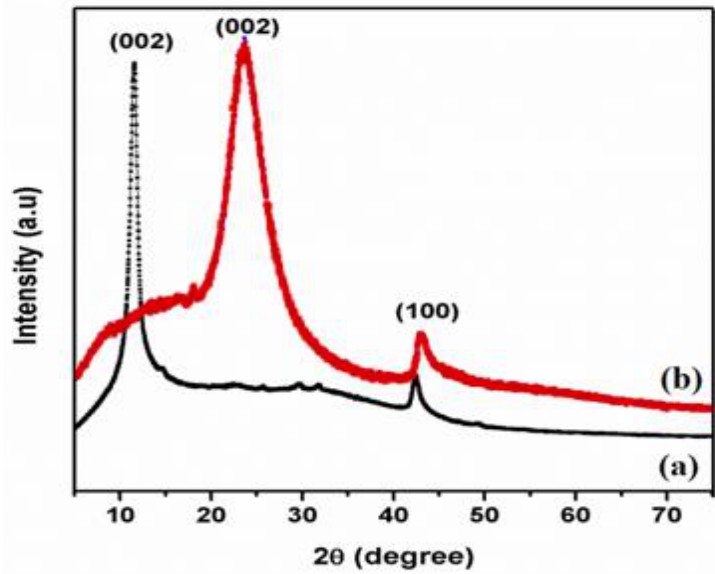
Figure 1. X-ray diffraction patterns of (a) GO and (b) T-rGO.